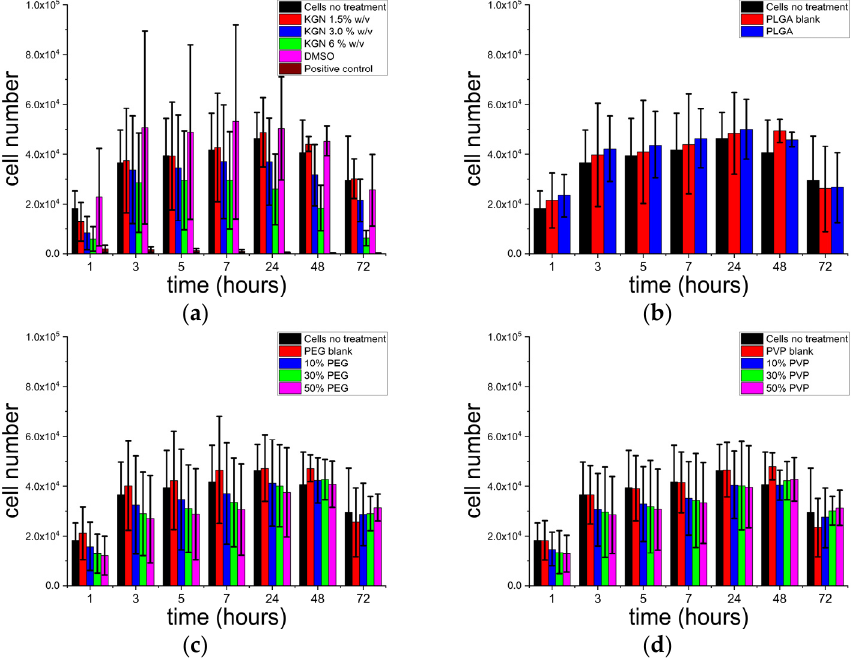
Figure 6. HOB cell numbers for ( a ) different concentrations of KGN; ( b ) PLGA formulations; ( c ) blended PLGA/PEG-KGN formulations; and ( d ) blended PLGA/PVP-KGN formulations. KGN- treated wells were exposed to different concentrations of KGN dissolved in DMSO/culture media, with the final concentration of DMSO being 0.1% v / v . DMSO control wells were treated with DMSO/media mixture at the same DMSO concentration. ‘Positive control’ are the wells that were treated with 100% ethanol. Statistical analysis using ANOVA revealed no significant differences between the formulations and negative